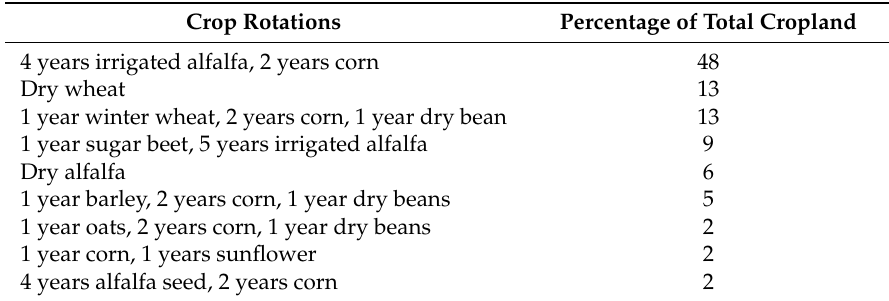
Table 1. Crop rotations and prevalence of their practice in Goshen County, Wyoming.